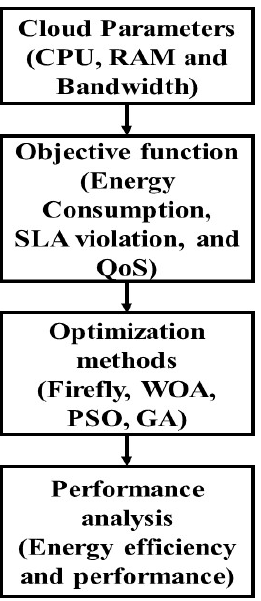
Figure 3. The energy optimization overall model.